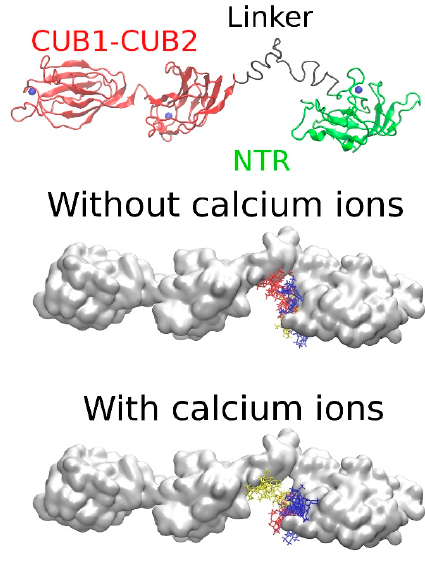
Figure 6. Molecular docking results for the models of the full-length PCPE-1 SAXS Model in the absence and presence of Ca 2 + ions and HP dp6. The clusters of docking solutions are shown in blue, red and yellow (from the most to the least populated clusters). NTR domain: green; CUB1-CUB2: red; the interdomain linker between the CUB2 and NTR domains: black.